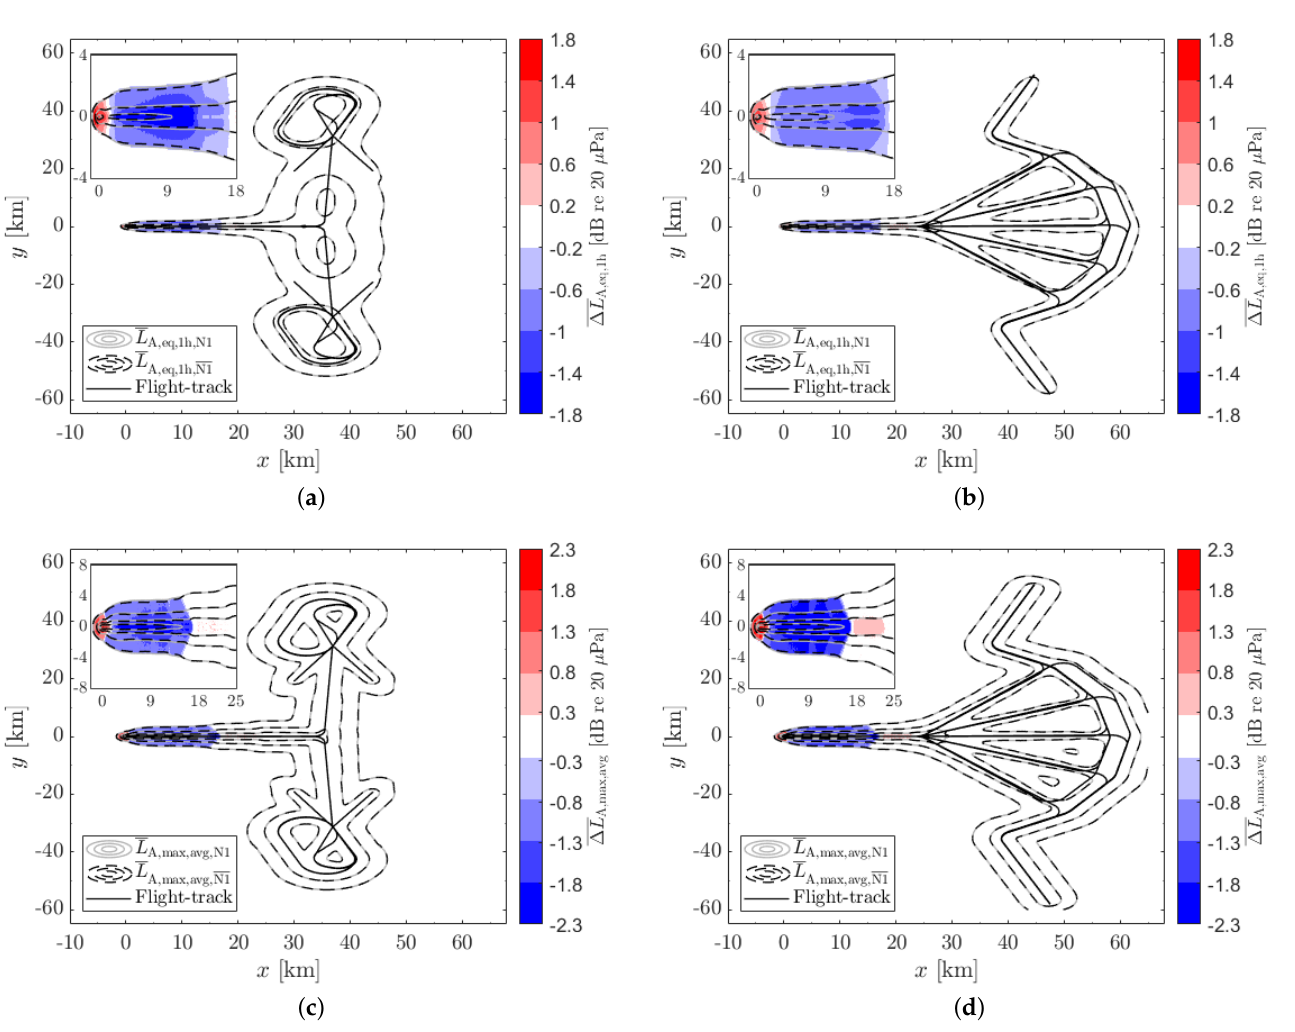
Figure 12. Influence of the N1 values in terms of ( a , b ) ∆ L A,eq,1h and ( c , d ) ∆ L A,max,avg for the vertical holding stack (left column) and the linear hold point merge (right column). Inset figures show the noise contours close to the runway. Results obtained considering the Scenario C. For the sake of clarity, only flight trajectories calculated based on the performance of the Airbus A320 are